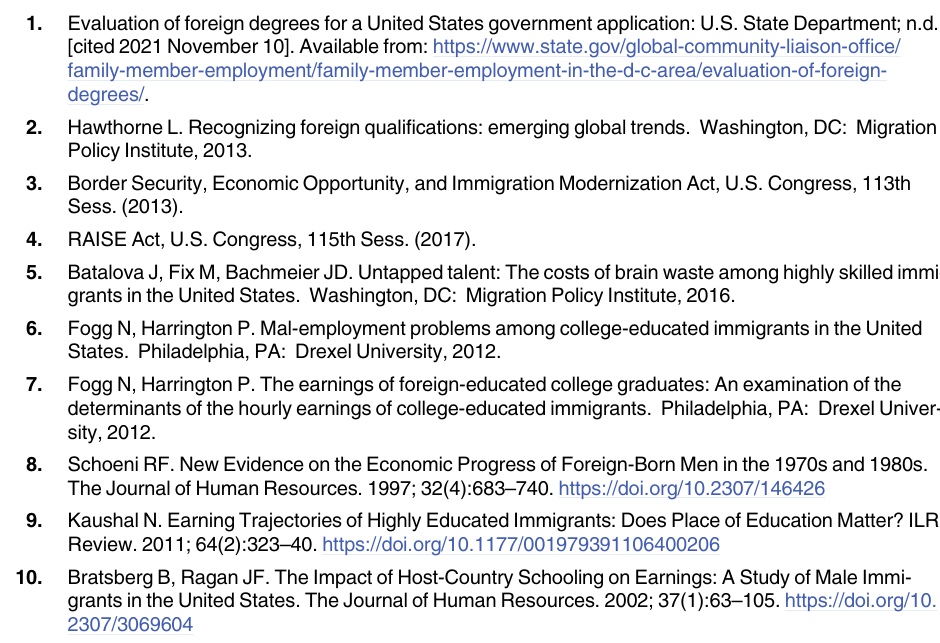
S2 Table. Effect of controlling for test scores on the immigrant-native wage and skilled employment gaps, with immigrants separated by years of U.S. residency. The first two col- umns display the coefficients from an OLS regression of the log of hourly wages on different sets of worker characteristics. The differences between the foreign-educated coefficients in the first and second columns are displayed in the bottom section. The last two columns display the odds ratios from ordered logit regressions of occupational skill requirements on different sets of worker characteristics. The ratios of the foreign-educated coefficients in the third and fourth columns are displayed in the bottom section. Standard errors are in parentheses. � p < 0.05, �� p < 0.01. To comply with government disclosure restrictions, sample sizes have been rounded to the nearest